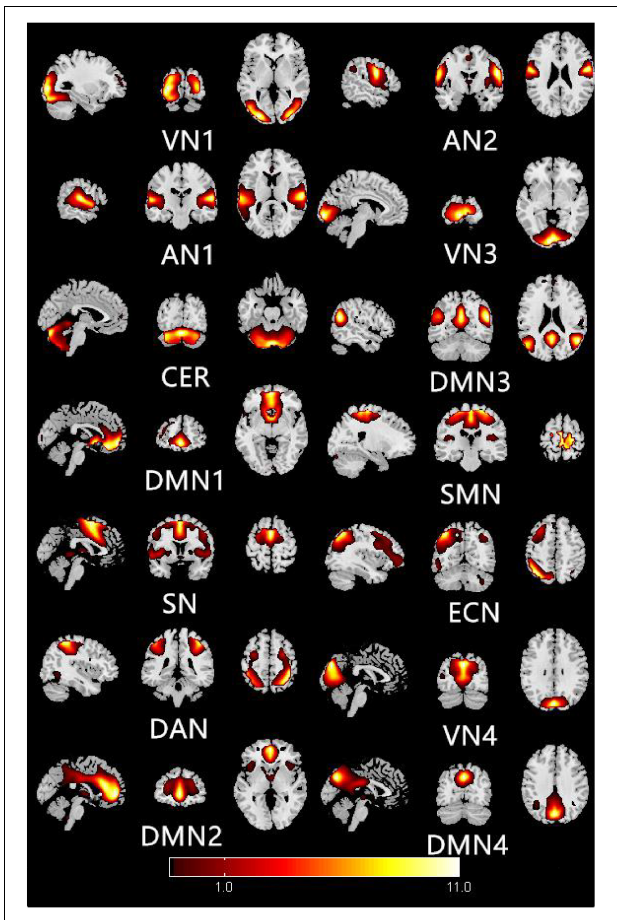
FIGURE 1 | Typical spatial patterns of each RSN in HM group: visual network (VN), auditory network (AN), cerebellar network (CER), default mode network (DMN), sensorimotor network (SMN), saliency network (SN), executive control network (ECN), and dorsal attention network (DAN).